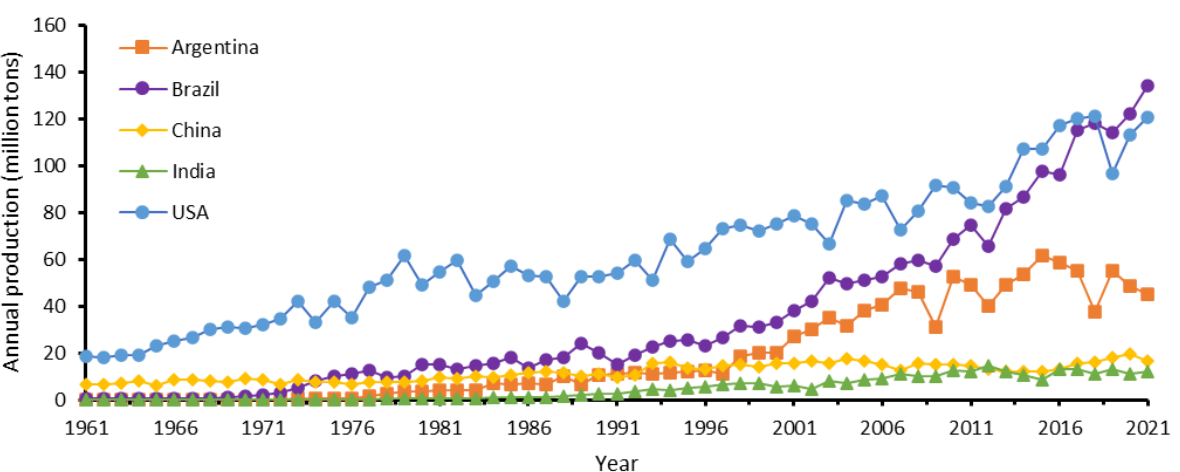
Figure 1. Soybean production in the five major soybean-producing countries from 1961 to 2021. Data from 1961 – 2019 were retrieved from FAOstat (https://www.fao.org/faostat/en/) on 1 February 2022. Data from 2020 were retrieved from USDA (https://ipad.fas.usda.gov/cropexplorer/Default.aspx) on 1 March 2022.